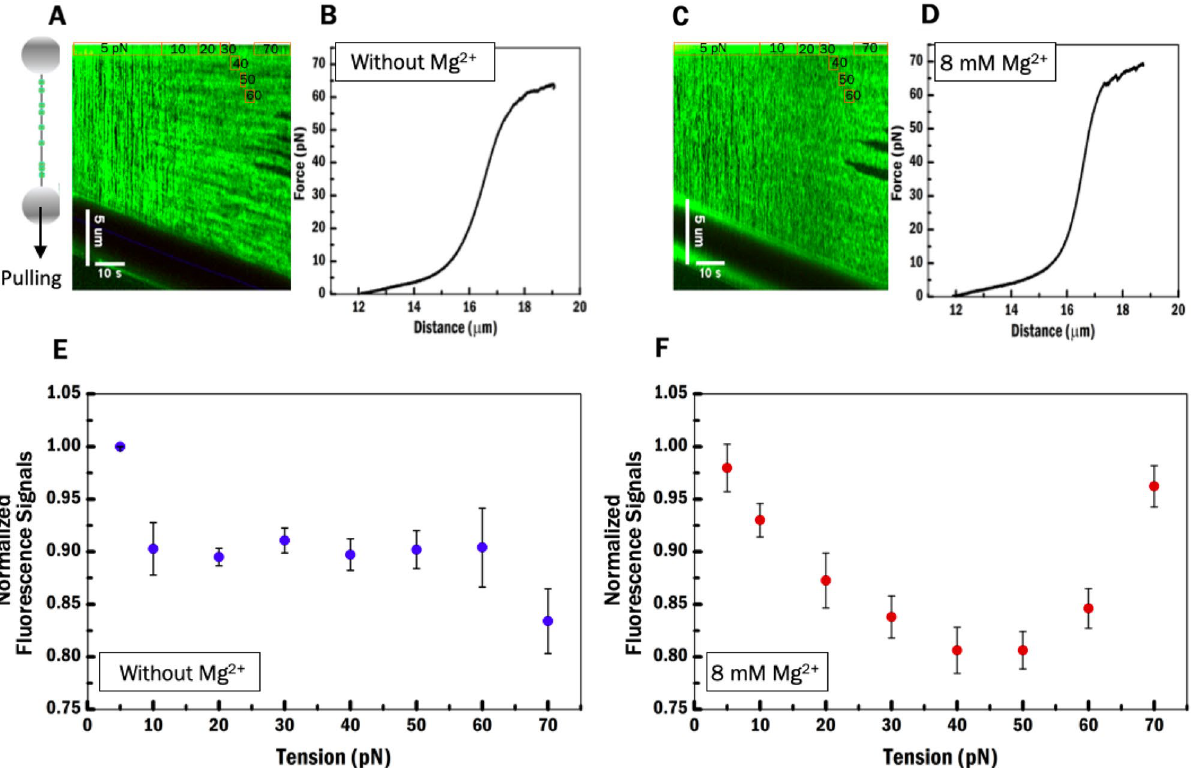
Figure 4. Visualization of fluorescently labelled HU protein along DNA at different tensions with and without 8 mM Mg 2+ . ( A ) Left is an illustration of a DNA pulling experiment. ( A , B ) Show a kymograph of fluorescence data and a FD curve obtained for the same molecule as the adjacent kymograph data without Mg 2+ . ( C , D ) Show a kymograph of fluorescence data and a FD curve obtained for the same molecule as the adjacent kymograph data with 8 mM Mg 2+ . Experiments were recorded in 40 nM Alexa555-HU protein channel. ( E , F ) Show the normalized fluorescence signals of the HU–DNA complex within 10 pN tension ranges without or with 8 mM Mg 2+ , respectively. Numerical values are an average of five experiments. The error bars represent the SE (standard